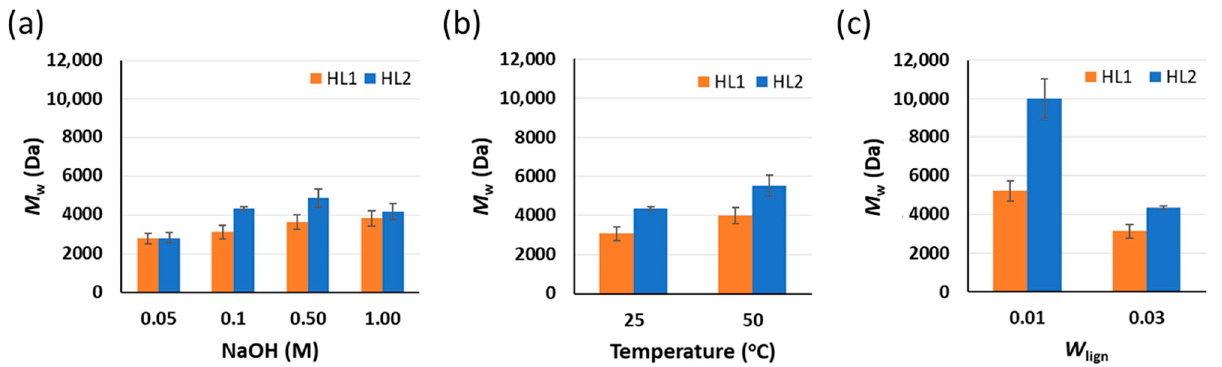
Figure 4. Influence of ( a ) NaOH concentration (T = 25 °C, initial W lign = 0.03); ( b ) temperature (0.1 M NaOH, initial W lign = 0.03); and ( c ) initial weight % lignin (0.1 M NaOH, T = 25 °C) on the average M w of the obtained purified lignin (PL) fractions for HL1 and HL2 lignins. Standard deviation error bars of duplicate experiments.